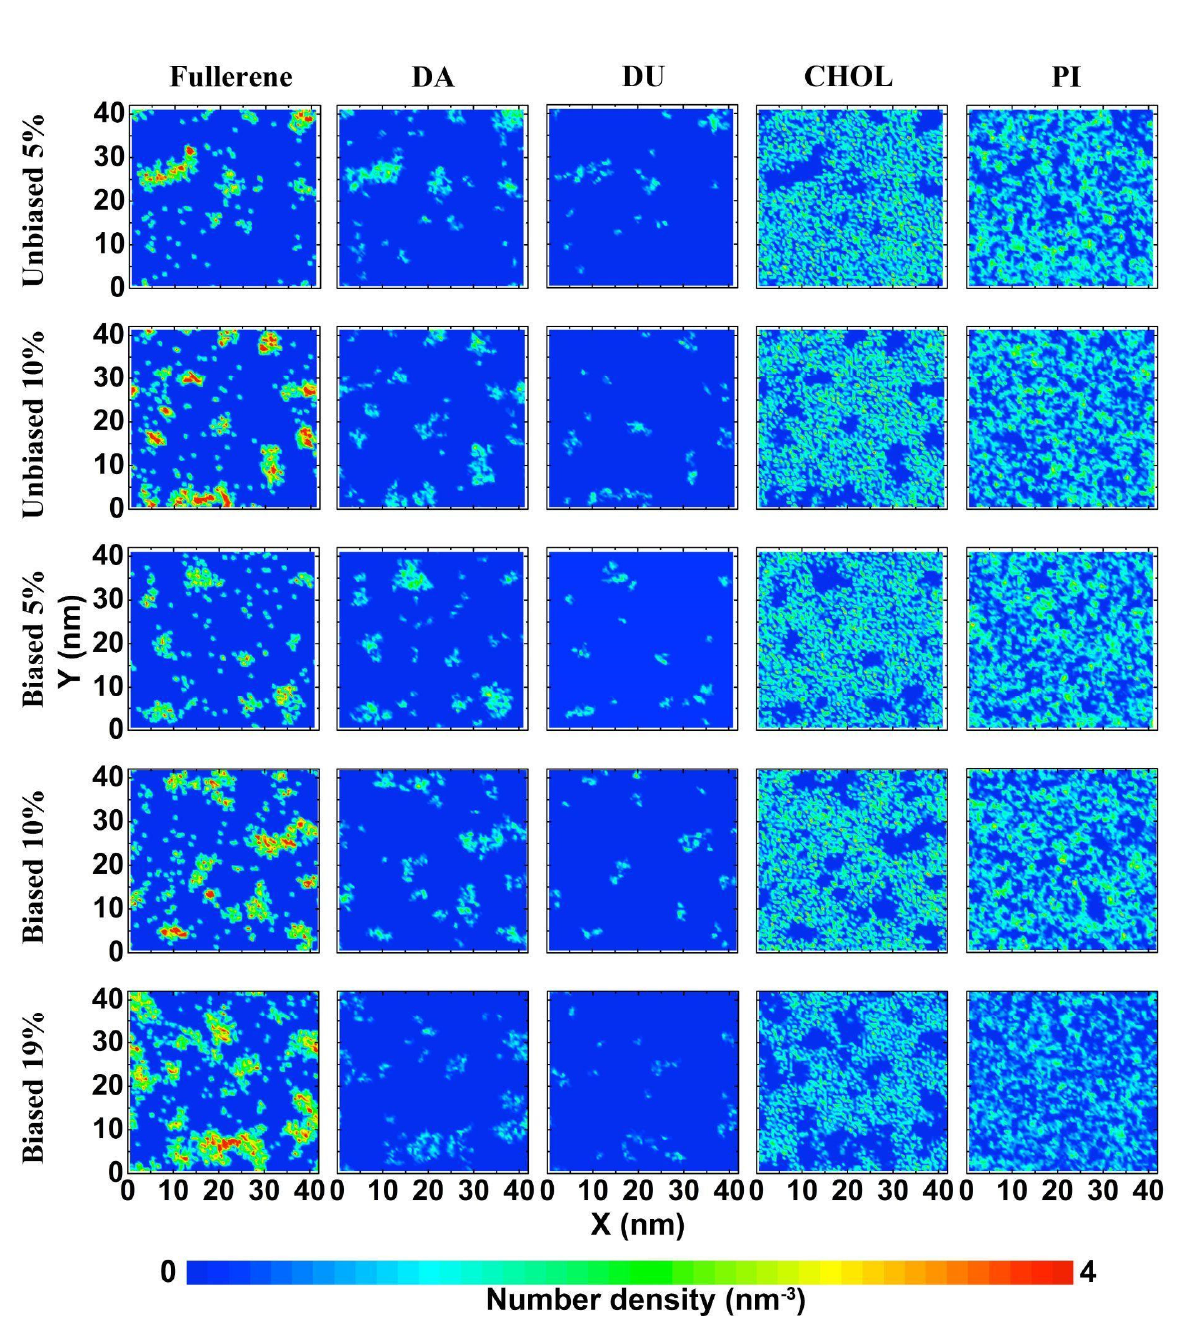
Figure 4. 2D density maps of fullerenes, cholesterol, and the lipid tails (DA, DU, PI) in biased and unbiased simulations at fullerene concentrations of 5%, 10%, and 19%. Each density plot after 10 µs of simulation. The density maps are colored by relative enrichment (red) or depletion (blue). Table 2. Mean square error (MSE) values comparing the average fullerenes and each type of lipid tail location for the inner and outer leaflets together over the last 5 µs.